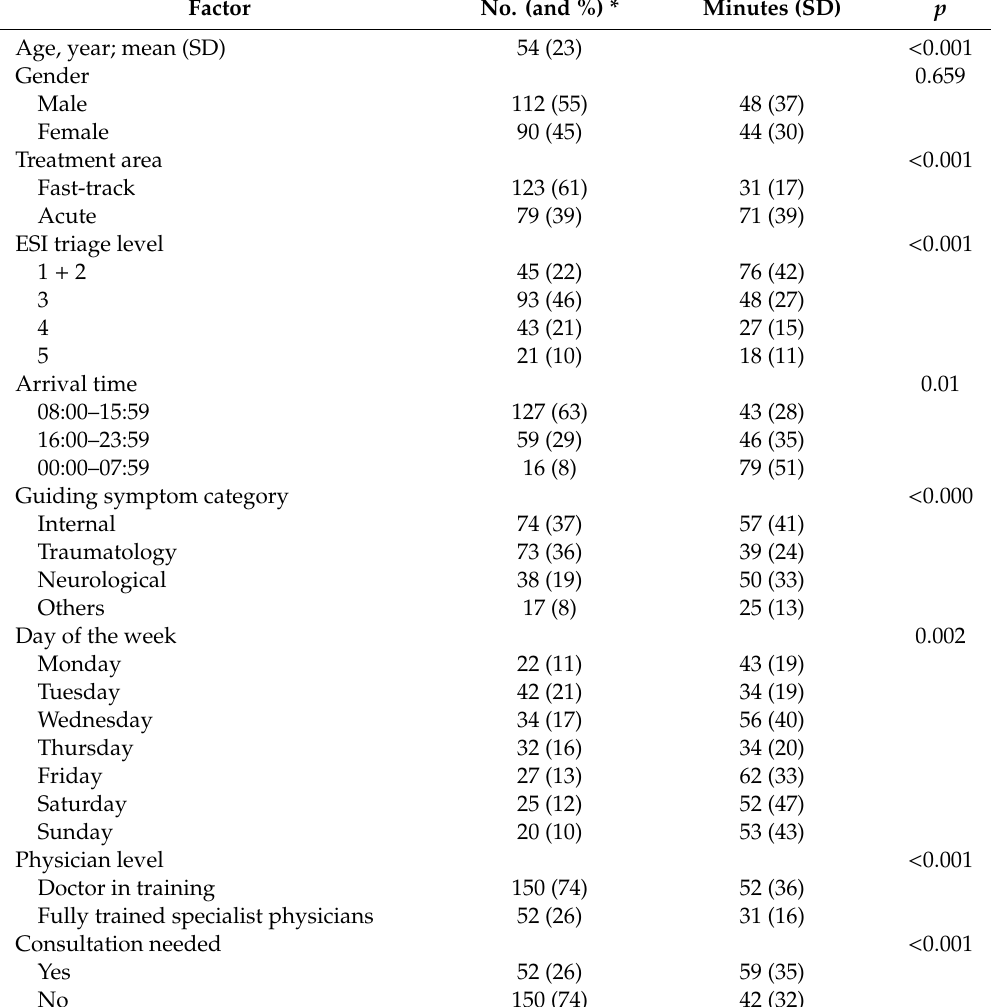
Table 1. Characteristics of the data sample, including the impact and significance level of the factors influencing the mean physician time per patient (MPTPP) in univariate